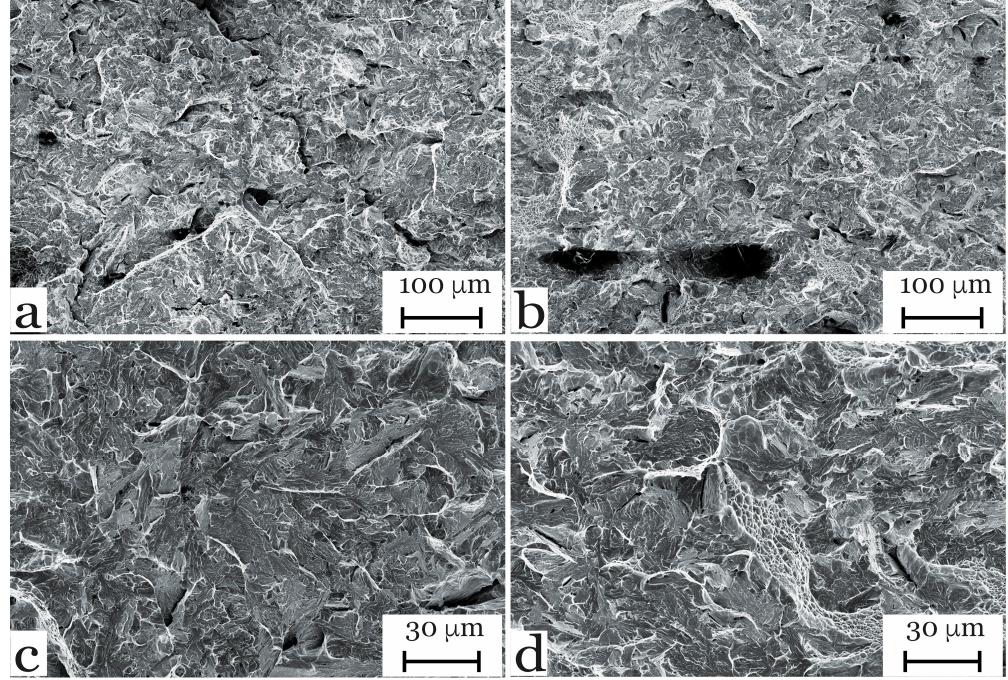
Figure 11. Brittle fracture surfaces (scanning electron microscope, SEM) of ( a , c ) 0Mo steel and ( b , d ) 0.25Mo steel.